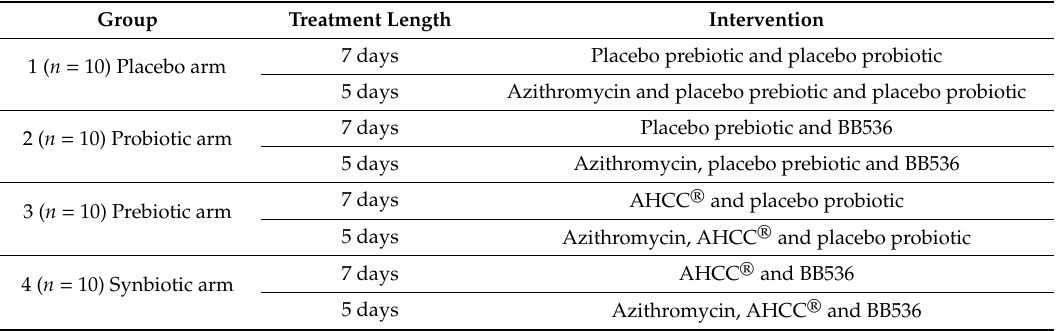
Table 1. Summary of healthy volunteer randomisation and treatment regimens. Group Treatment Length